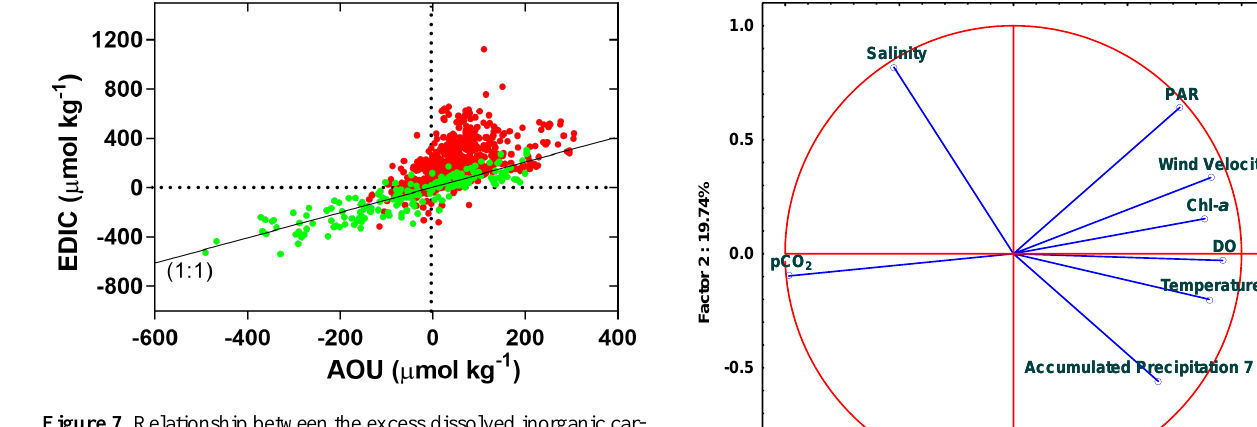
Figure 7. Relationship between the excess dissolved inorganic car- bon (E-DIC) and apparent utilization of oxygen (AOU) in Guan- abara Bay (green dots) compared to those reported in 24 estuarine environments (red dots; Borges and Abril, 2011). The 1 : 1 line rep- resents the quotient between CO 2 and O 2 during the processes of photosynthesis and respiration.